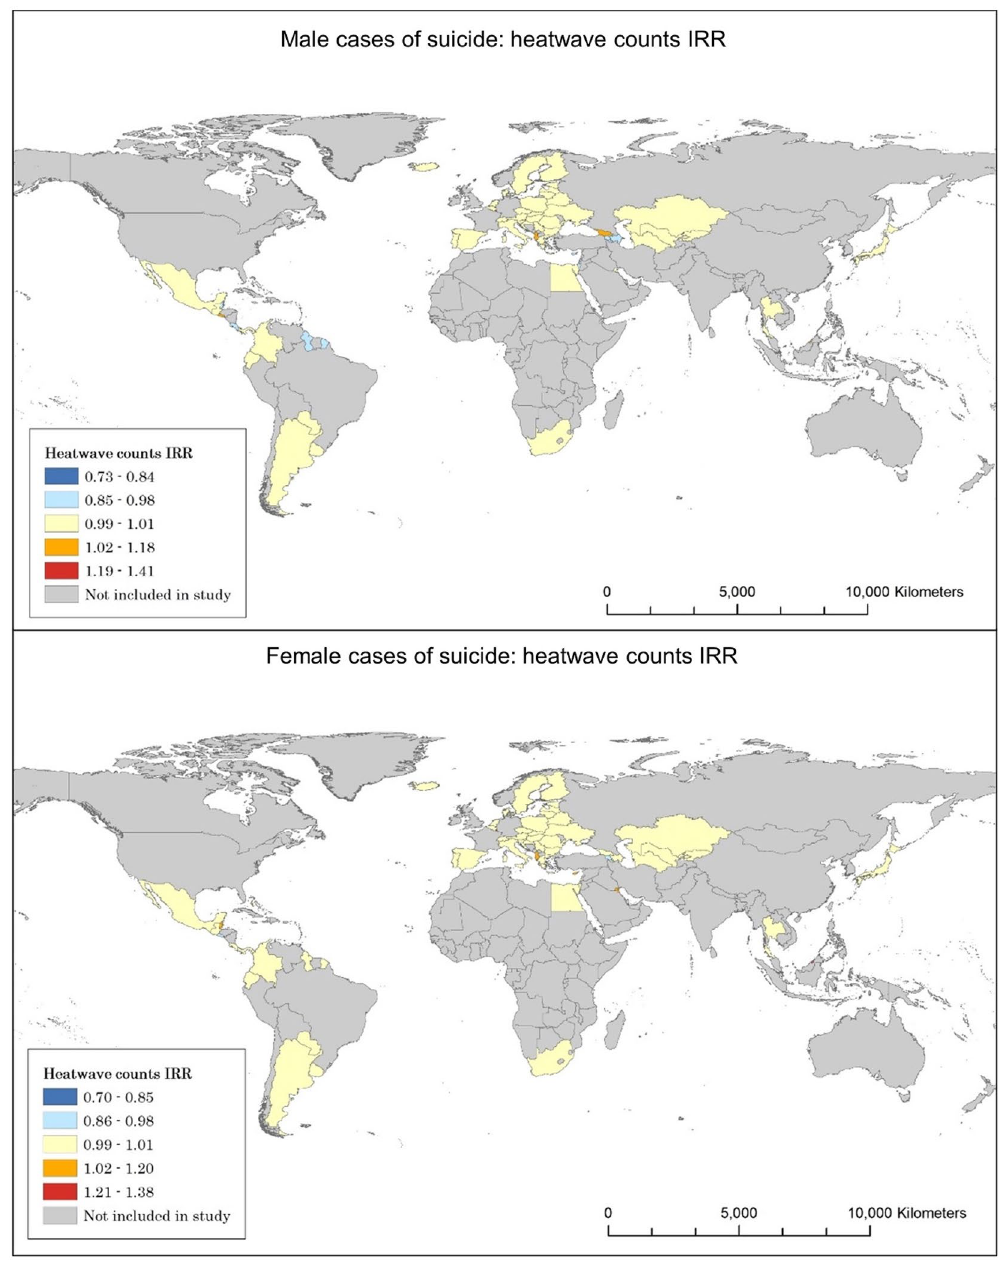
Figure 1. Heatwave and suicide correlations for males and